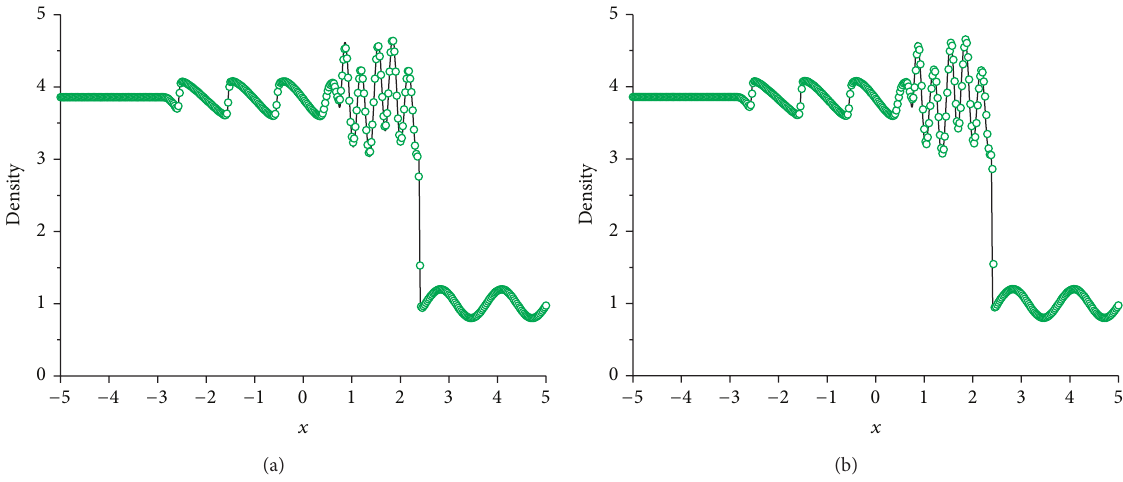
Figure 5: The numerical results of the shock-turbulence interaction problem at 𝑡 = 1.8 with CFL = 9.9 , 𝑁 = 400 ; (a) M-SL-FV WENO 5 scheme; (b) M-C-SL-FD WENO 5 scheme; solid line: exact solution; circle: computed solution.